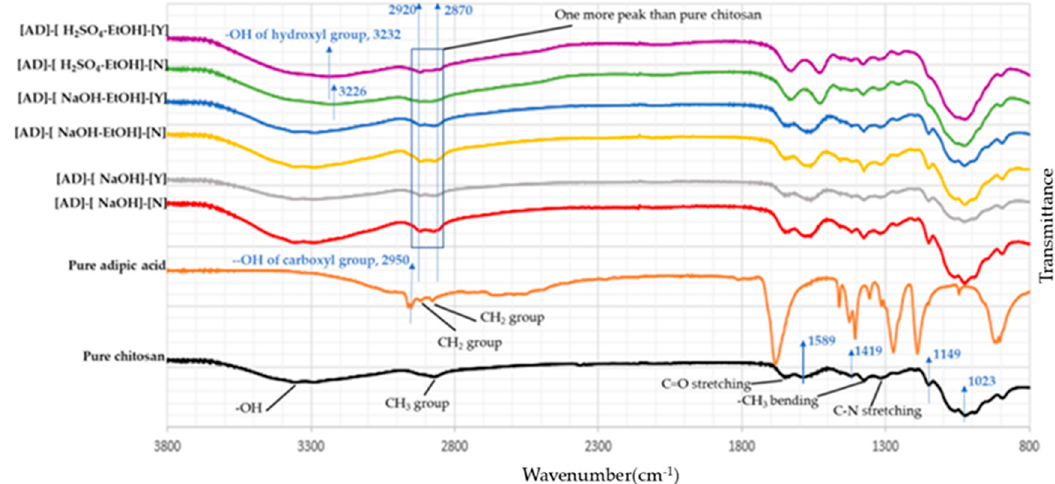
Figure 4. FTIR spectra of adipic acid monofilaments, pure adipic acid and